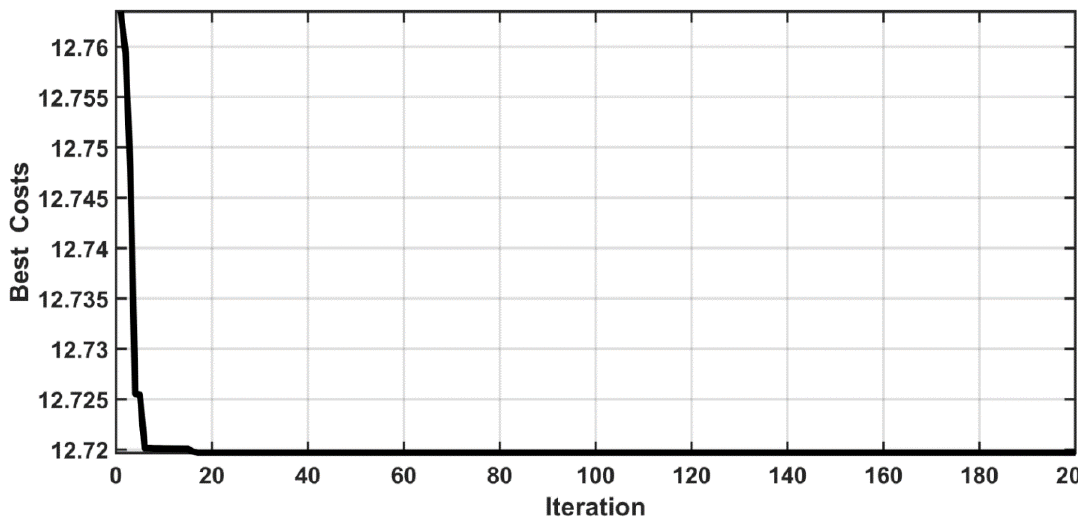
Figure 4. The cost-function behavior of ASC-controlled system using PSO algorithm.